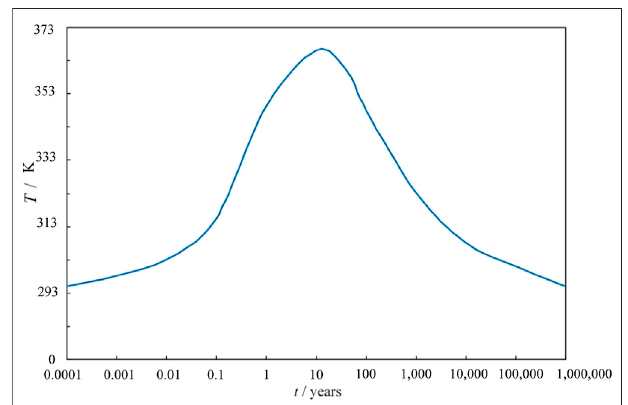
FIGURE 1 | Temperature evolution with time near HLNW container for